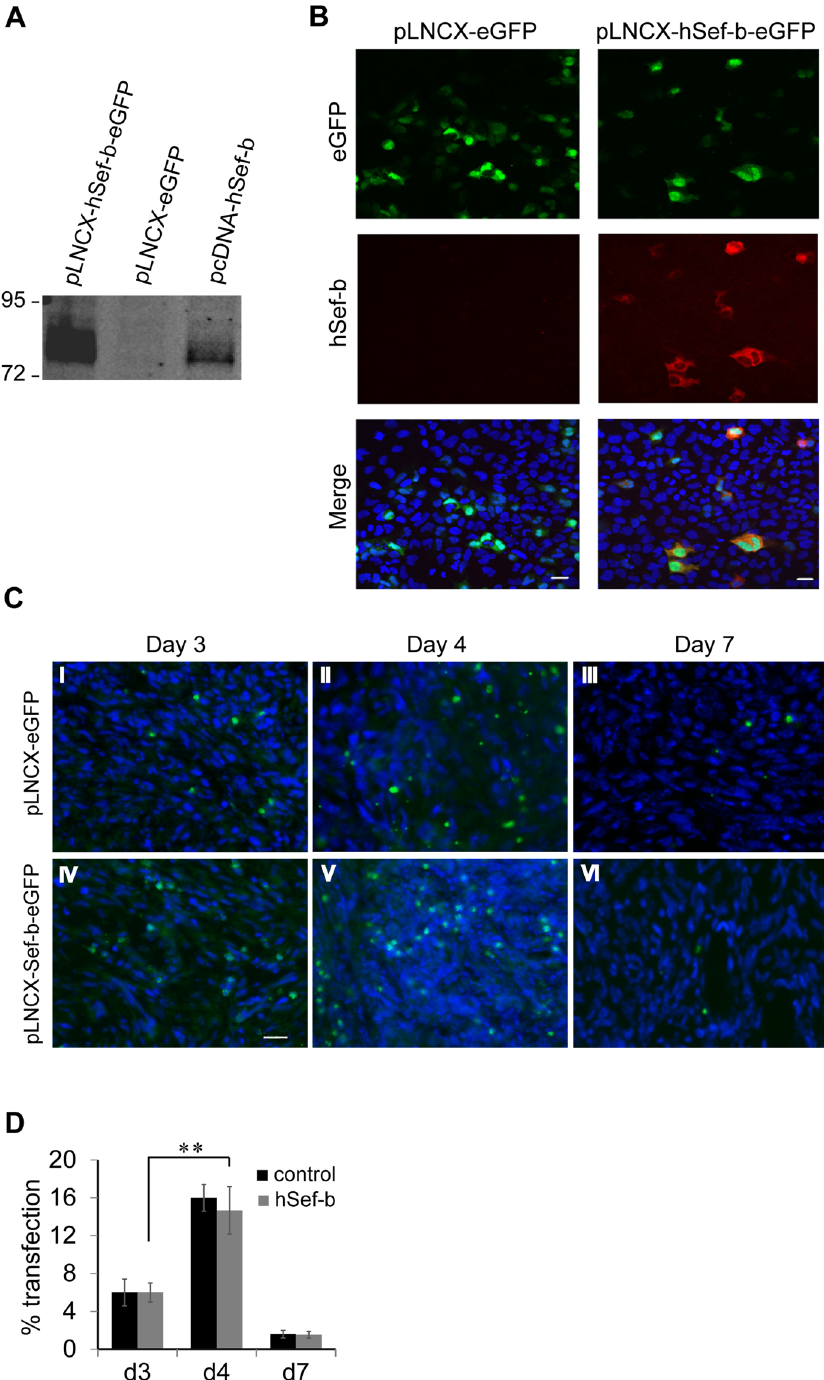
Figure 2. ( A , B ) Co-expression of hSef-b/eGFP in vitro . HEK 293 cells were transfected with pLNCX-eGFP, bicistronic pLNCX-hSef-b/eGFP vector or pcDNA3.1/hSef-b. Whole cell lysates were subjected to Western blot analysis with antibody directed against myc-epitope tag that is fused to hSef-b protein ( A ). Cellular expression of hSef-b was analyzed by IF using anti-myc antibody (red) and standard fluorescence microscopy. Bar: 10 μ m ( B ). ( C ) Kinetics of expression of eGFP reporter in vivo . Subcutaneous tumors were injected with control pLNCX-eGFP vector (I–III) or pLNCX-hSef-b/eGFP vector (IV–VI) followed by a single TUS application. Micrographs are representative of 3 sections taken from each mouse (N = 5). Tumor sections (20 µ m) from day 3, 4 and 7 post DNA transfection were examined by fluorescent microscopy. Bar: 20 µ m. ( D ) Quantification of transfection efficiencies in vivo . Micrographs are representatives of three sections taken from each mouse, five mice in each group. Transfection efficiencies were calculated using LUCIA Image Analyses ( ** P ≤